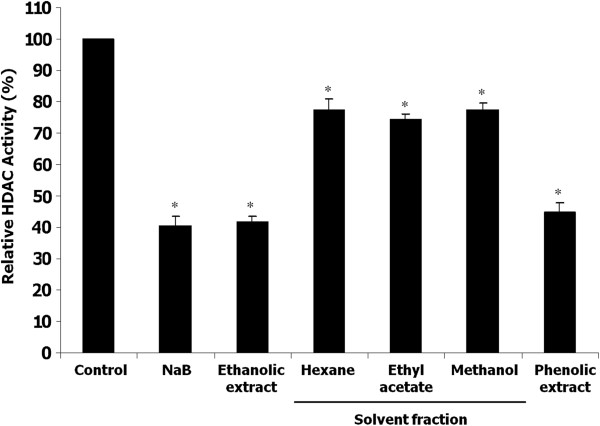
In vitro HDAC inhibitory activity of ethanolic crude extract, solvent extraction fractions, and phenolic-rich extract. The concentration of each sample in a reaction mixture was 200 μg/50 μl. Results were expressed as relative HDAC activity with respect to the vehicle control (DMSO). Sodium butyrate (NaB) was used as a positive control. Each value represents the mean ± SD of three experiments, performed in duplicate. Asterisks (*) denote significant differences vs control (p < 0.05).